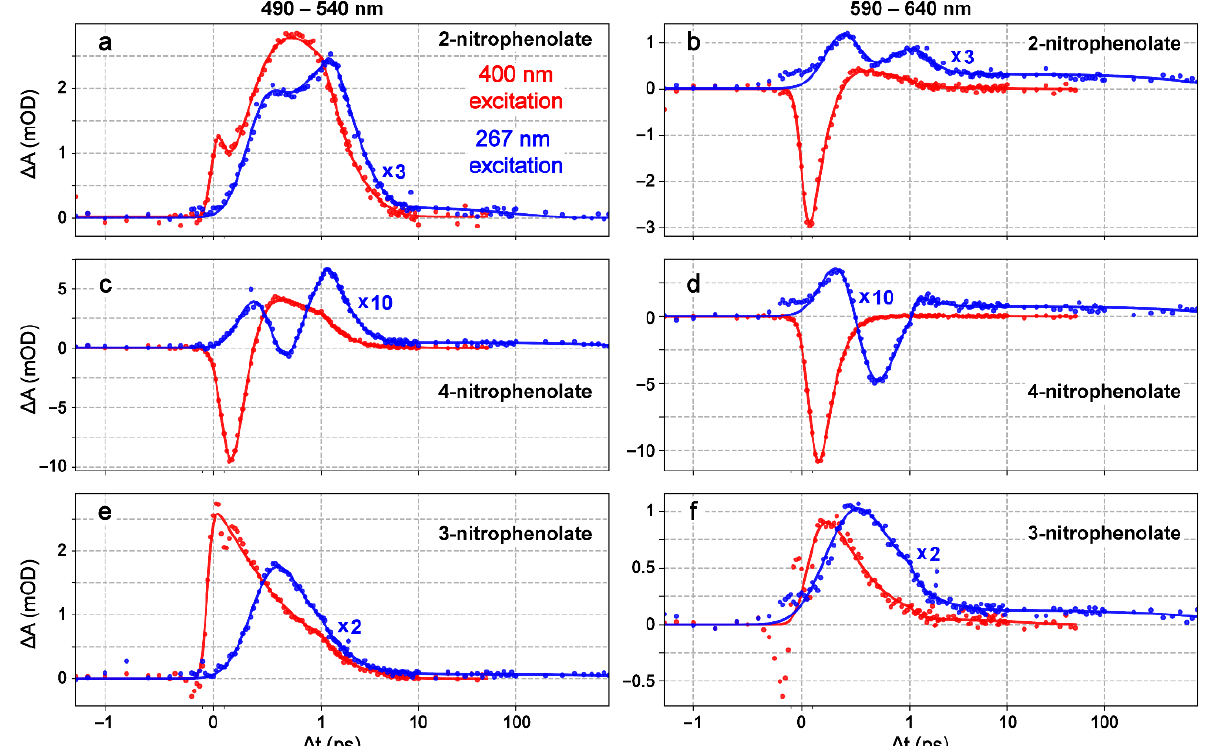
Figure 3. Fs-TA spectra of nitrophenolates in water at two different probe-wavelength ranges under 400 nm (red) or 267 nm (blue) excitation. Spectral data (filled dots) are averaged over the ranges of (left) 490–540 nm and (right) 590–640 nm for ( a , b ) 2NP − , ( c , d ) 4NP − , and ( e , f ) 3NP − , respectively, and overlaid with the best fits (color-coded solid lines) from the probe-dependent analysis (see Section 4.5 for detailed methods).